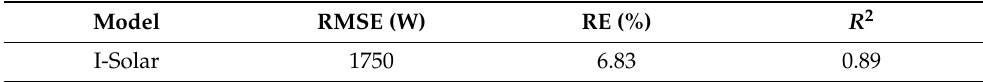
Figure 5. Statistical adjustment of the I-Solar model in direct current (DC). Table 7. Statistical analysis of the I-Solar model in DC.